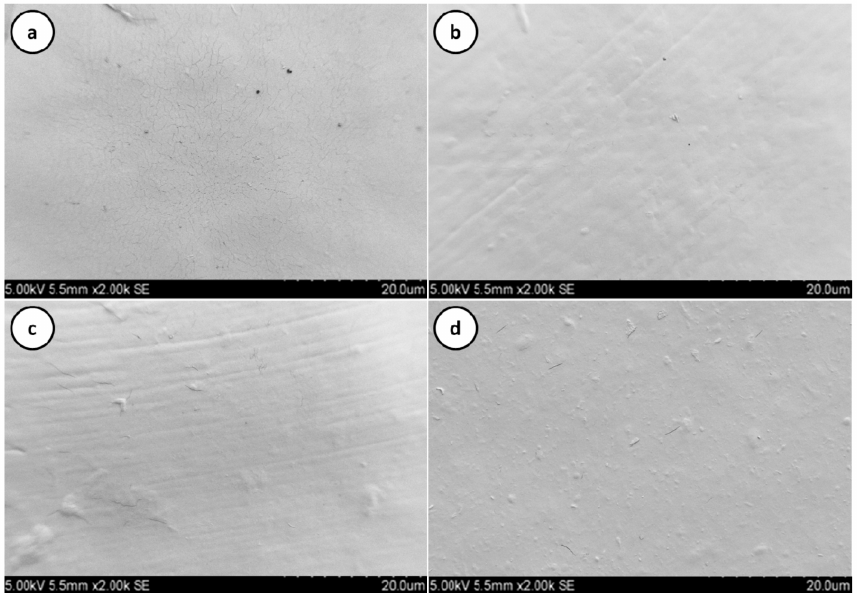
Figure 2. SEM micrographs of ( a ) starch-PVA film, ( b ) starch-PVA loaded with 1% CNPs, ( c ) starch- PVA film loaded with 3% CNPs, and ( d ) starch-PVA film loaded with 5%